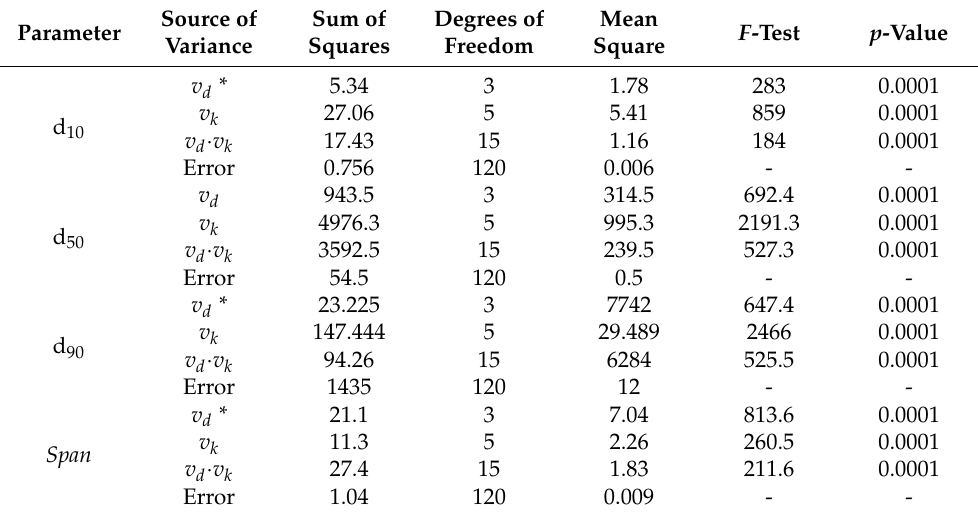
Span v d · v k 0.0001 Error 1.04 120 0.009 -